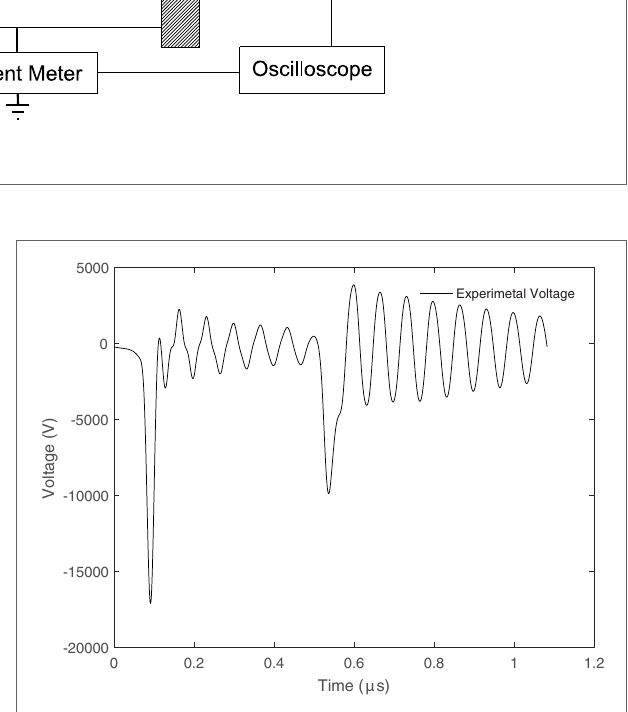
FigUre 5 | Typical signal of input voltage waveform.